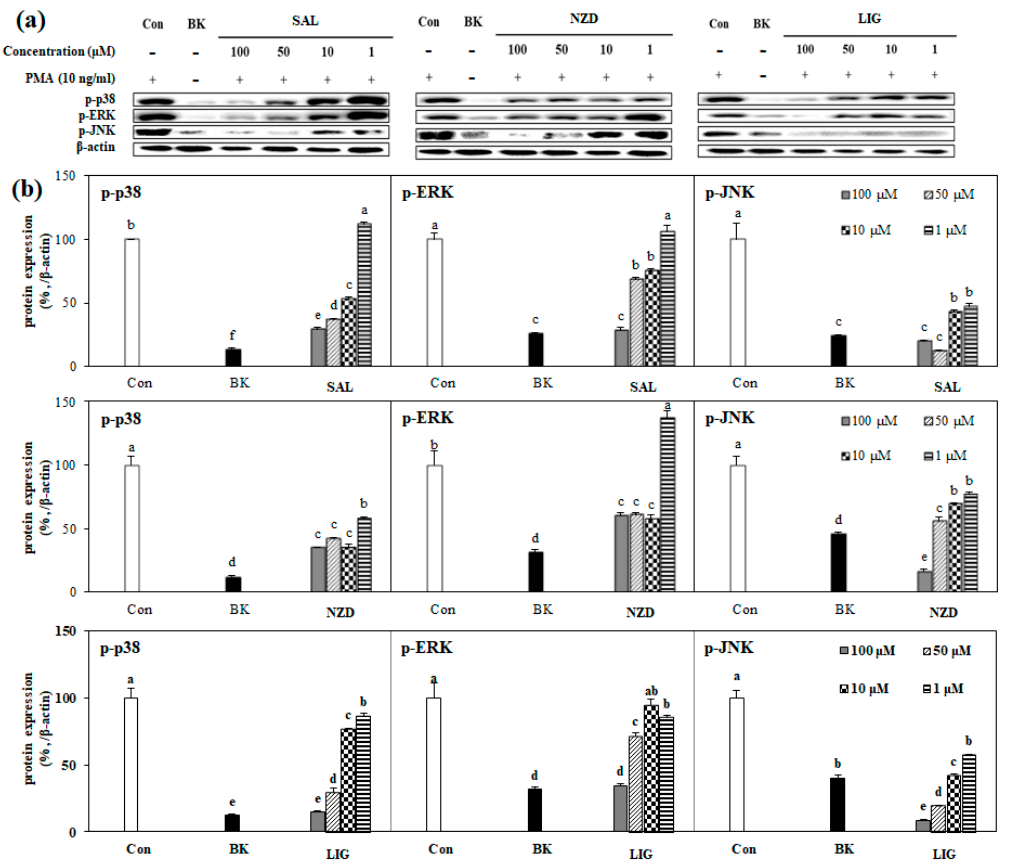
Figure 6. ( a ) Effects of SAL, NZD and LIG on protein levels of phosphorylated (p-) p38, ERK Figure 6. Effects of SAL, NZD and LIG on protein levels of phosphorylated (p-) p38, ERK and JNK by Western blot in and JNK by Western blot in HT1080 cells (Con: untreated PMA-stimulated cells; BK: HT1080 cells (Con: untreated PMA-stimulated cells; BK: untreated unstimulated cells). β -actin was used as the loading control. The MMP production in cells was stimulated with phorbol 12-myristate 13-acetate (PMA), and cells were subjected to treatment with isolated compounds. The phosphorylated protein levels were densiometrically calculated from band images and given as relative percentage of PMA-stimulated untreated control group (Con). Expression levels were normalized against house-keeping control, β -actin. a-e Means with different letters at the same concentration are significantly different ( p < 0.05), as assessed by Duncan’s multiple range test.